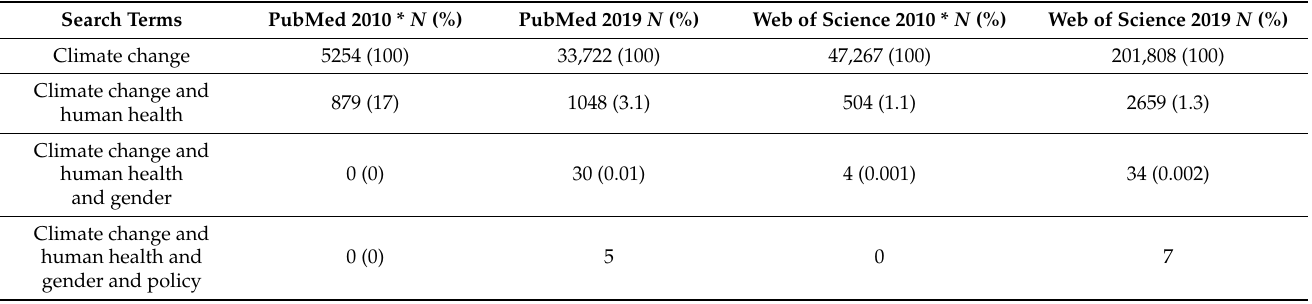
Table 1. Data base search according to Preet et al., 2010 [5], repeated on 26 March